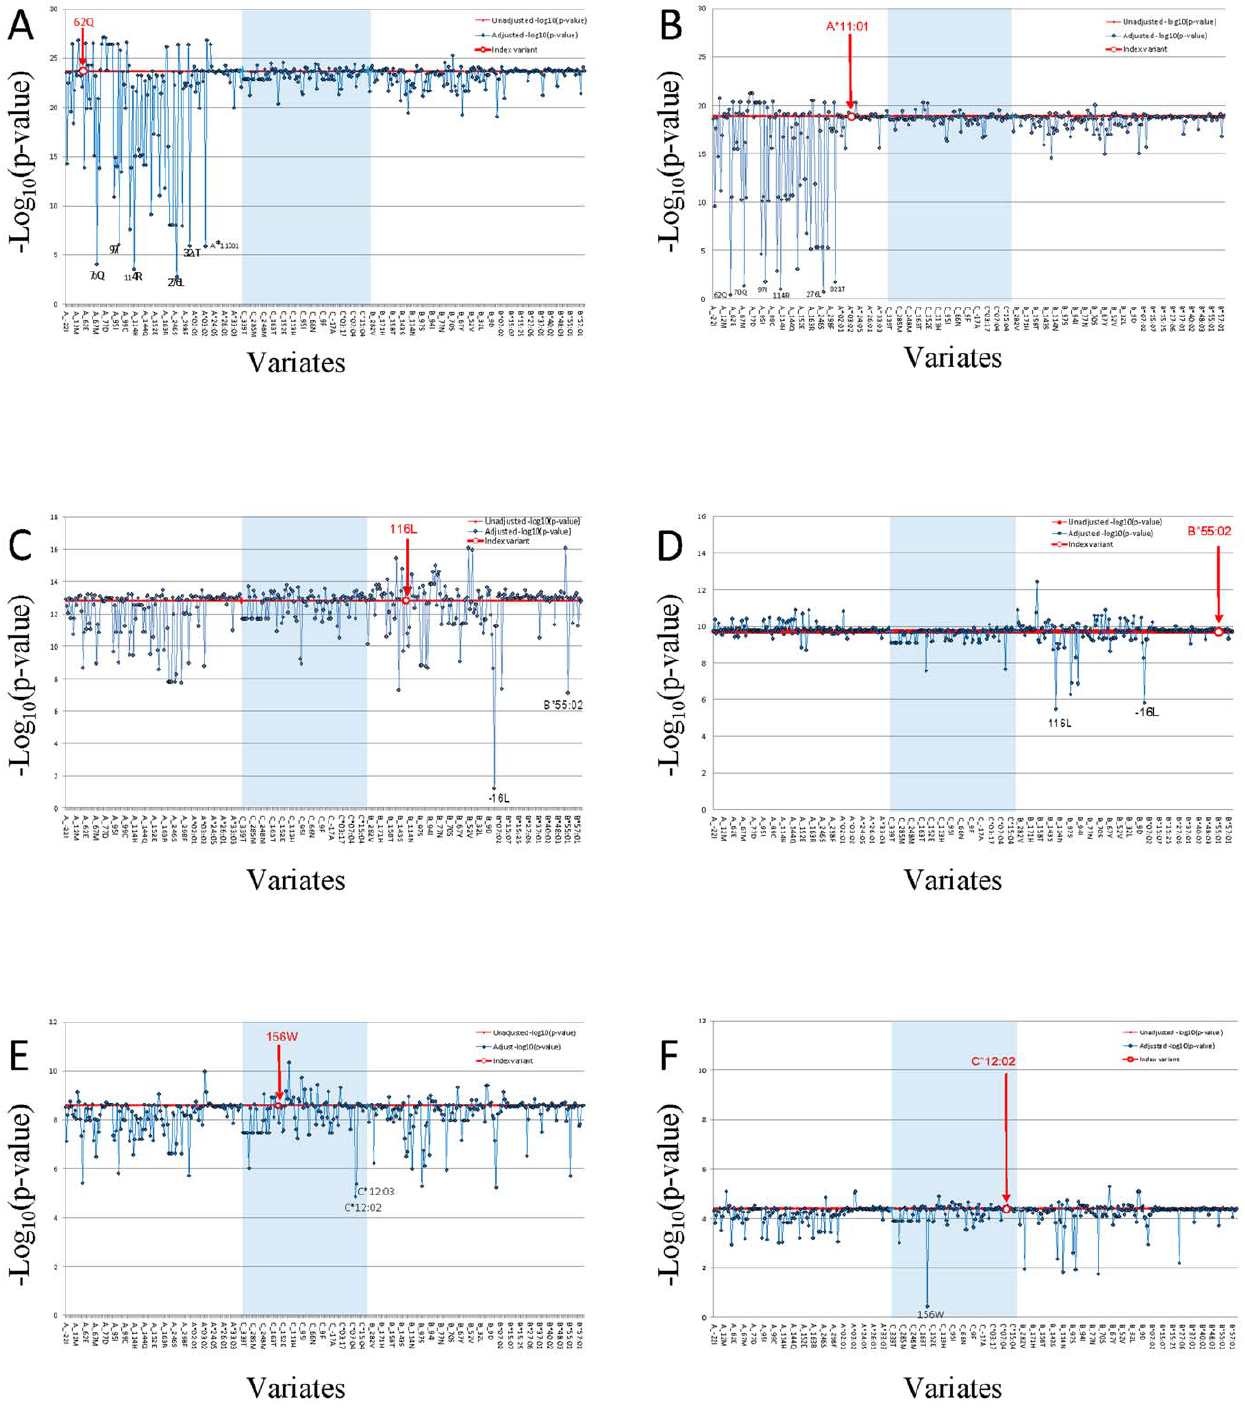
Figure 3. Proxy variant analysis for the strongest aa-variants or HLA allele in HLA-A, in HLA-B, and in HLA-C. Genetic association of each HLA amino acid variant was calculated. Study participants in both phase I and phase II (N=4055 study participants; Line V in Table S3). Multivariate conditional logistic regression analysis was performed to compute amino acid variants (A, C, and E) or HLA alleles (B, D, and F) association p-value. The HLA typing data set ( N =4055 study participants; Line V in Table S3) were used PLINK to examine the residual effect of index amino acid variant or HLA allele while using other amino acid variant or HLA allele as a covariate, and we adjusted the results for age and gender. The index amino acid variant or HLA allele was marked with bold red font. The red line indicated unadjusted –log 10 p of index. Three HLA class I genes regions were separated by light blue block of HLA-C gene between HLA-A and HLA-B. The X-axis is amino acid or HLA allele covariate, ranking by their coordinate. HLA alleles were group together ranking by allele names in each HLA class I gene locus. The Y-axis is the –log 10 p of index variant adjust by covariate. Independent variants should not change the adjusted p-values from the strong unadjusted values of the index variant, while LD-proxies would reduce their p-values appreciably depending upon the strength of LD.